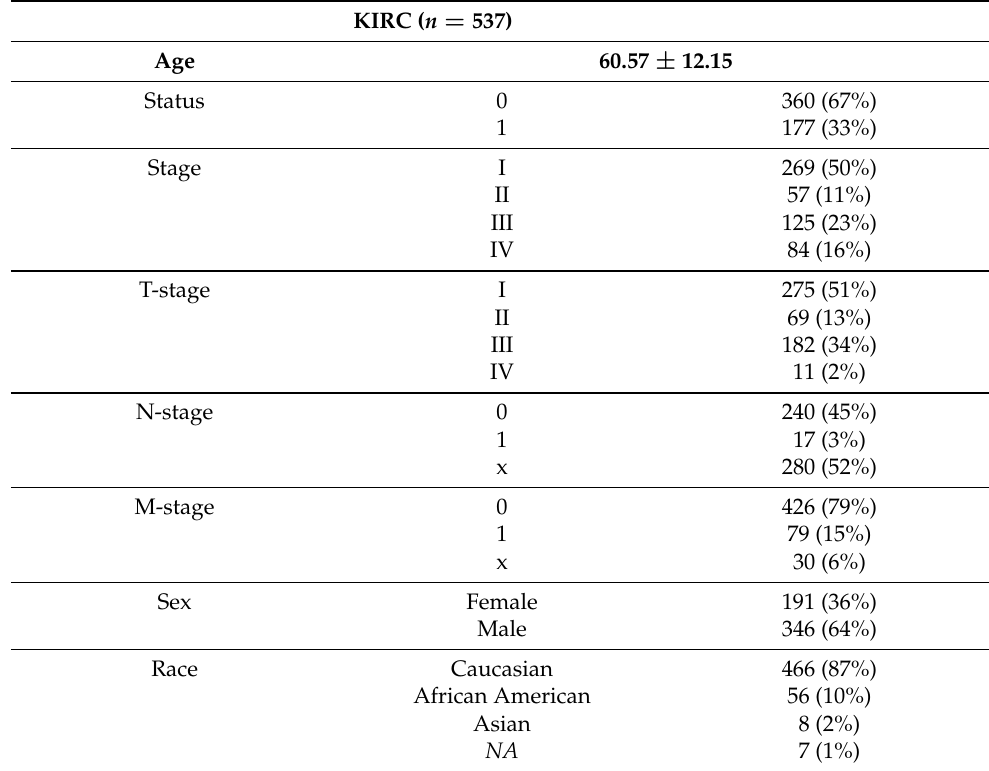
Table 1. Data distribution regarding each clinical variable of interest: age (mean ± standard devia- tion), status (dead = 1 and alive = 0), stage (I, II, III and IV), T-stage (I, II, III and IV), N-stage (0 = not yet spread to nearby lymph nodes, 1 = spread to nearby lymph nodes), M-stage (metastasis = 1 and no metastasis = 0), sex (female and male) and race (Caucasian, African American,